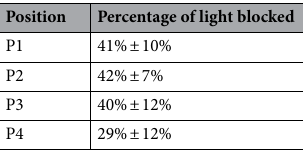
Table 3. Proportion of light blocked by hanging T-shirts at each location within the disinfection cabinet (± standard deviation).